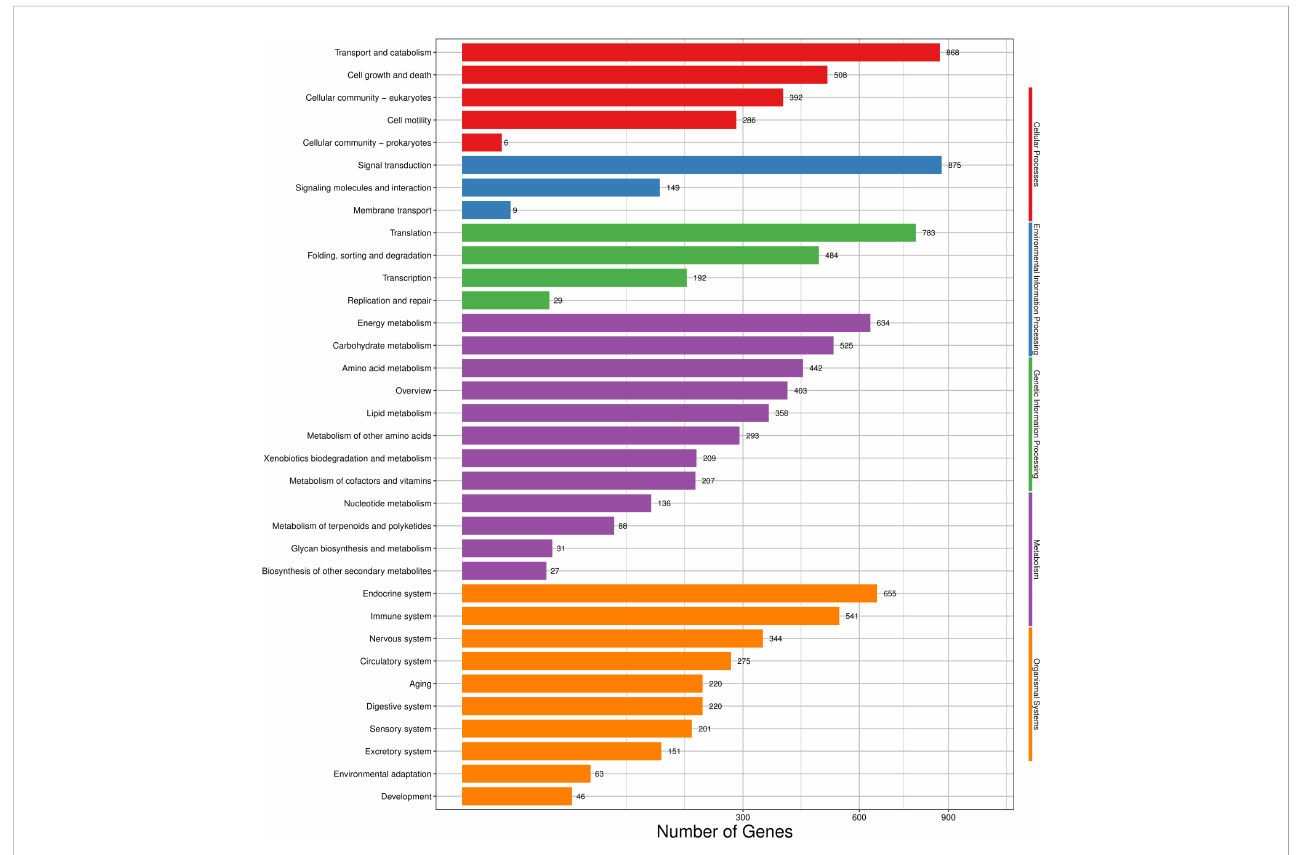
FIGURE 3 KEGG classi fi cation of H. cunea transcripts. Red, blue, green, purple and orange represent cellular processes, environmental information processing, genetic information processing, metabolism and organismal systems, respectively. The x-axis represents the number of transcripts; the y-axis represents KEGG pathway